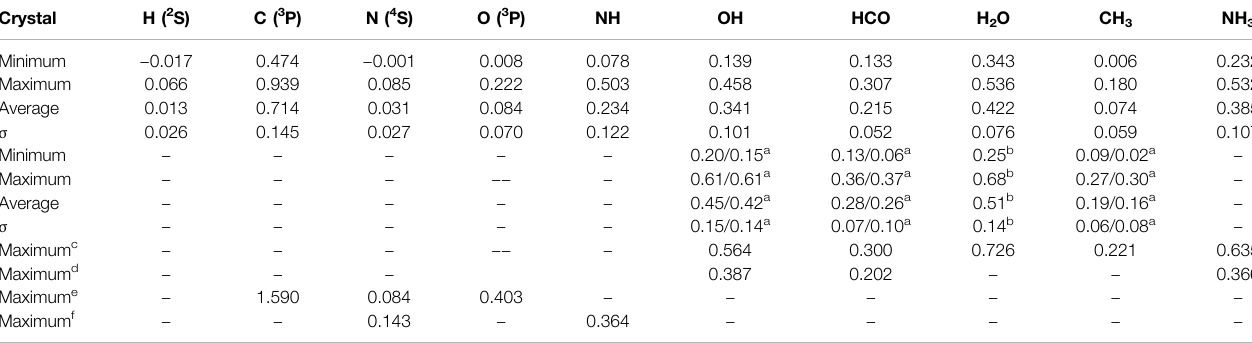
TABLE 4 | Calculated BE ’ s at CBS/DLPNO-CCSD(T):PM6//ONIOM( ω B97X-D/6 – 31+G**:PM6) including ZPE for crystalline structures.